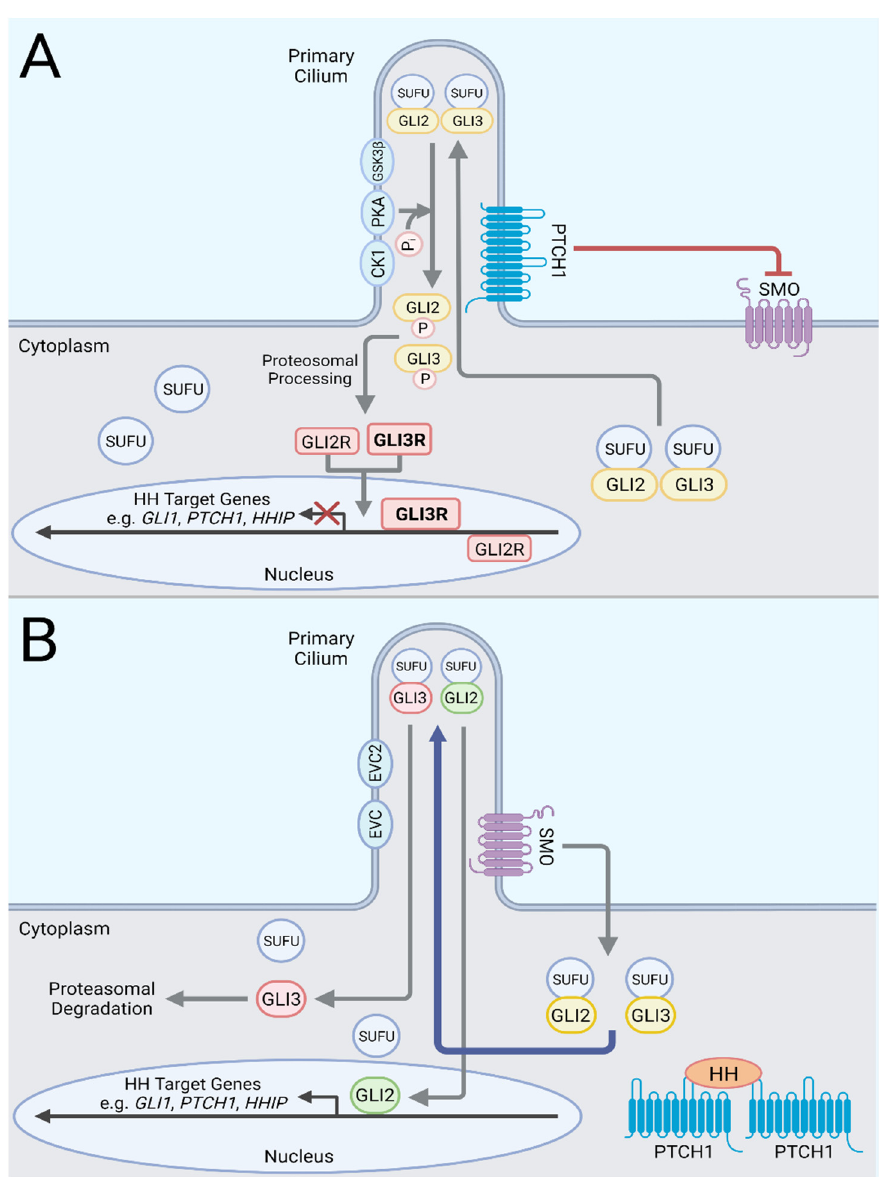
Figure 1. A Simplified Schematic of the Canonical Hedgehog Signaling Pathway. ( A ) Pathway Off. In the absence of a Hh ligand, PTCH inhibits SMO. GLI2 and GLI3, bound to SUFU, traffic to the primary cilia. PKA, CK1, and GSK3 β phosphorylate the GLI factors for proteolytic cleavage to their repressor forms, which translocate to the nucleus to inhibit the transcription of Hh pathway target genes. GLI3R (bold) is the major transcriptional suppressor. ( B ) Pathway On. A Hh ligand binds to PTCH to relieves its inhibition of SMO. With SMO activation, SUFU bound to GLI translocates to the primary cilium. EVC and EVC2 promote SUFU dissociation from GLI factors. GLI2, the primary activating GLI factor, then translocates to the nucleus to initiate transcription of Hh pathway target genes. GLI3 undergoes proteasomal degradation. Created with BioRender.com.